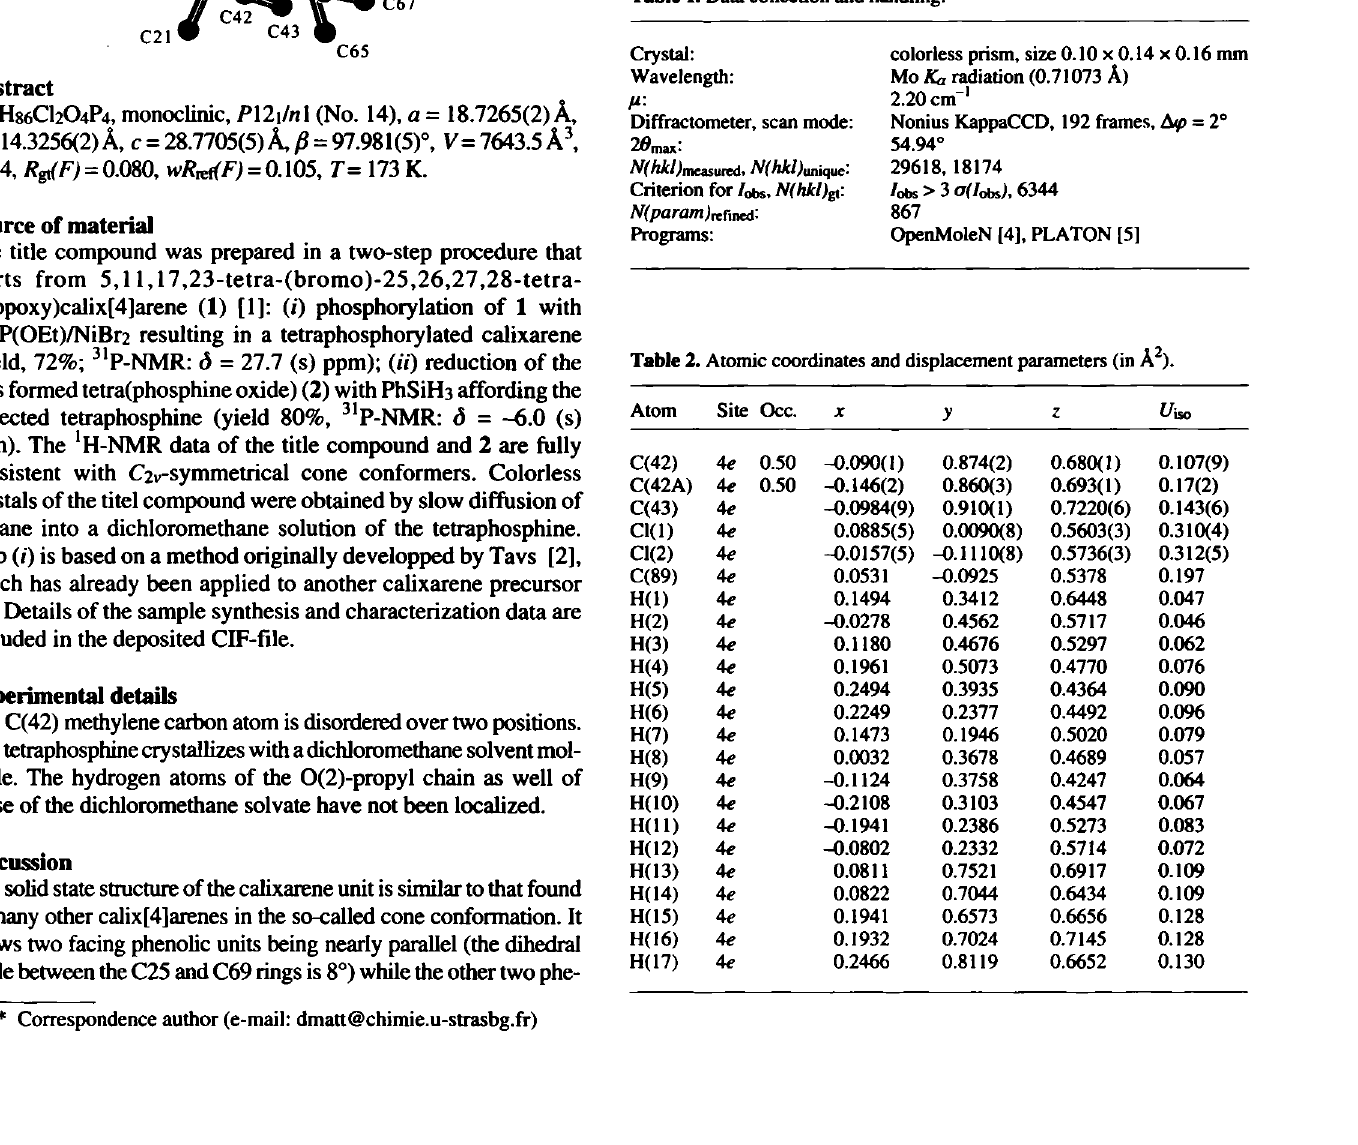
Table 1. Data collection and handling.